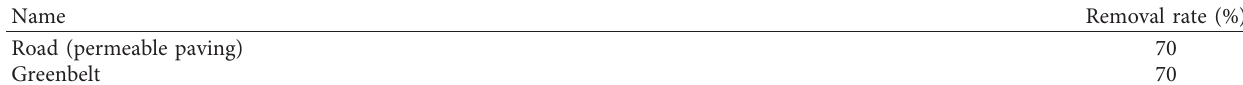
Table 6: Standard table of the removal rate of suspended solids (SS).